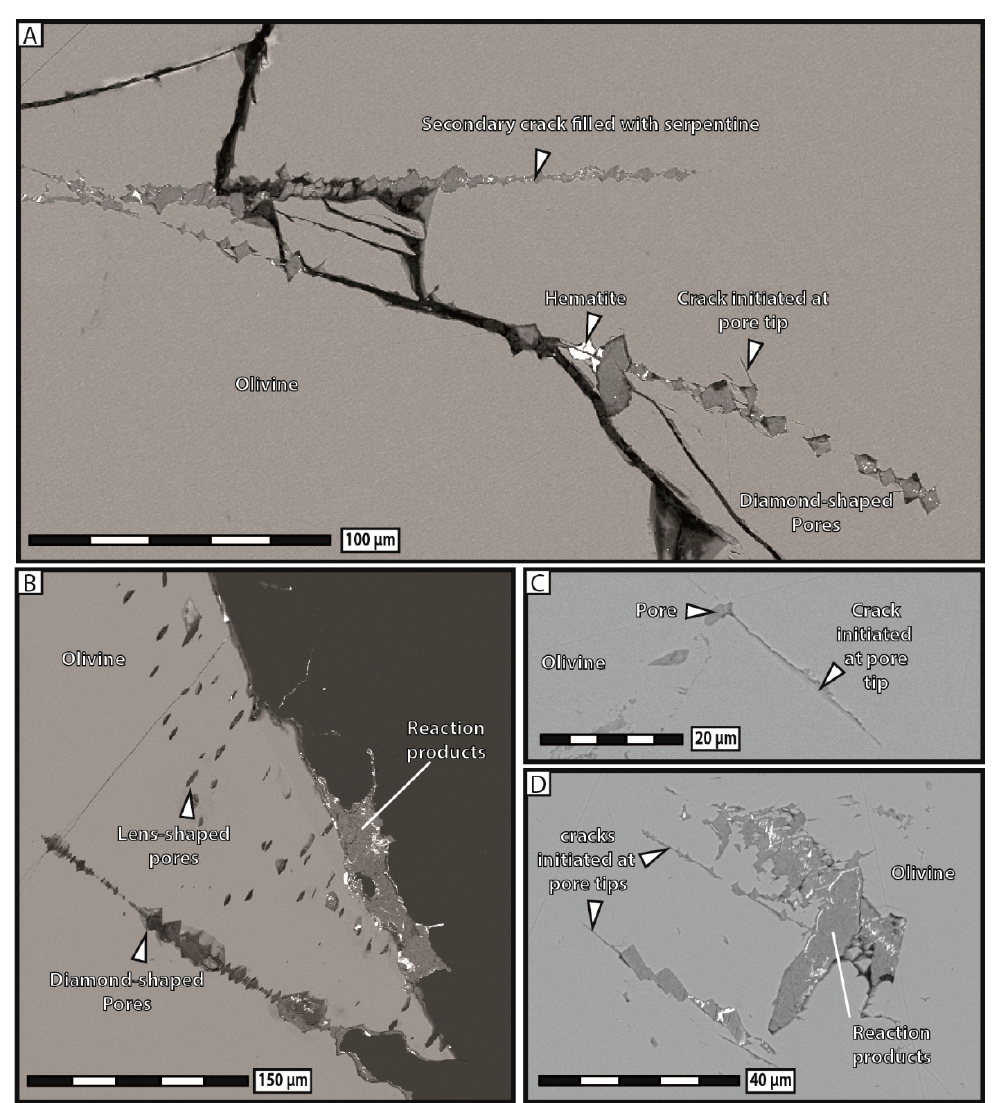
Figure 9. BSE images of porosity features after reaction in NaHCO 3 solution. ( A ) Diamond-shaped pores filled with reaction products and lining up along secondary cracks. ( B ) Oblong and lens-shaped pores scattered in the outer parts of olivine grains. Some pores were filled with reaction products while other have remained empty. ( C , D ) Juvenile cracks initiated at the tips of diamond-shaped pores filled with reaction products. ( A , B ) are for t = 6 months (run # 5), and ( C , D ) for t = 12 months.